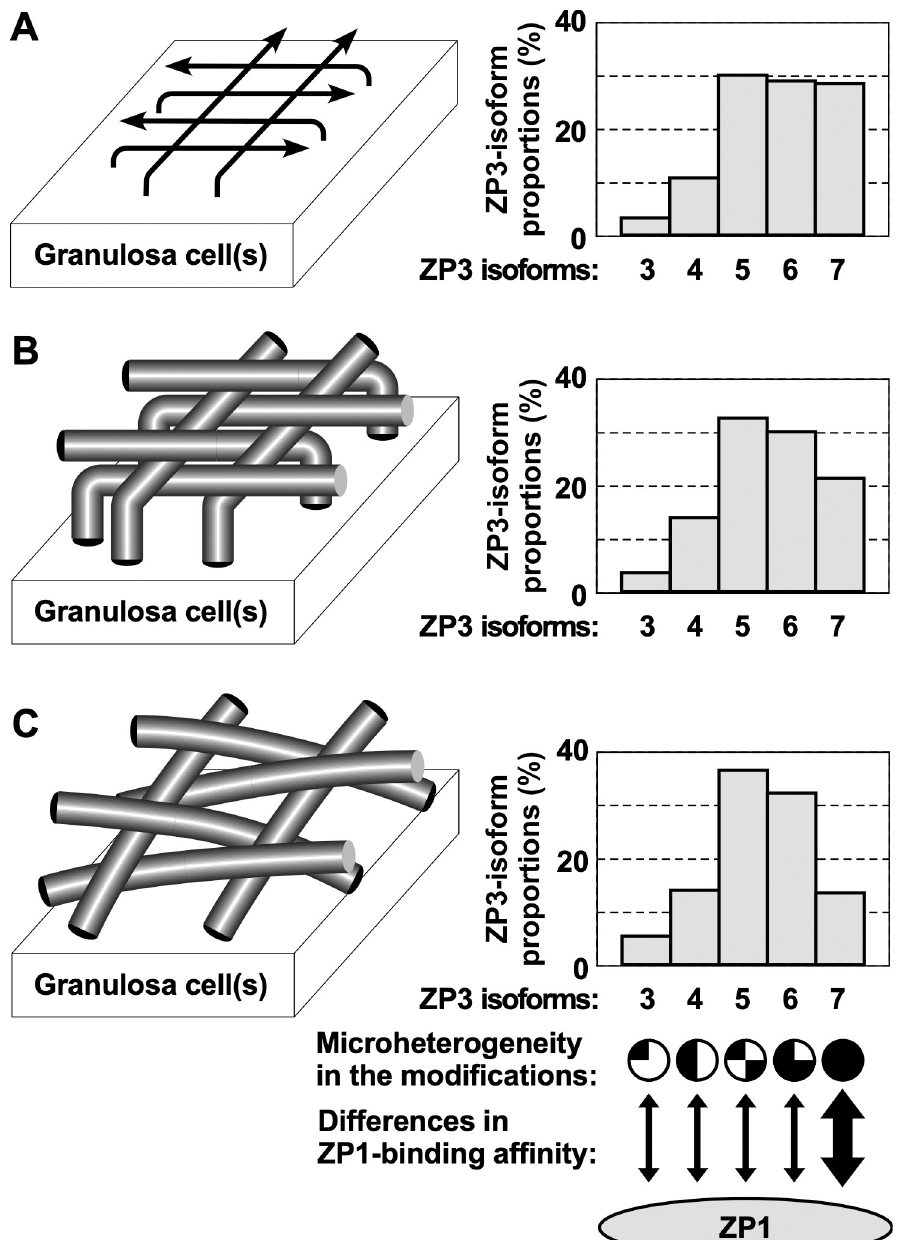
Fig 7. Graphical summaries of key findings in this study. (A) The left scheme shows that in the IPVL of yellow follicle F3, the assembly of the egg-coat matrices may be initiated at the one surface adjacent to the ZP3 secreting granulosa cell(s) and proceed to the other surface being accompanied with the formation of fibrous structures as shown by arrows . (B) The left scheme shows that the quick development of the egg-coat matrices in the IPVL of yellow follicle F2 may be mainly associated with the extension and thickening of individual fibrous structures associated with the rapid growth of the ovarian follicle. The fibrous structures in the F2 IPVLs may be organized vertically from the surface adjacent to the granulosa cell(s) and exposed on the other surface to be arranged horizontally. (C) The left scheme shows that in the yellow follicle F1 just before ovulation, internal fibrous structures of the egg-coat matrices appear to be more horizontal than that in the yellow follicle F2 probably because of the lateral extension of IPVLs with the continuous thickening of the fibrous structures being accompanied by the mechanical tension during the rapid growth of the ovarian follicles from F2 to F1. Interestingly, the proportions of ZP3 isoforms 3 to 7 are differentially altered through the rapid growth of yellow follicles from F3 to F1 ( bar graphs A to C, respectively), and these ZP3 isoforms contain the isoform-dependent modifications at least in the F1 IPVL, respectively (conceptually